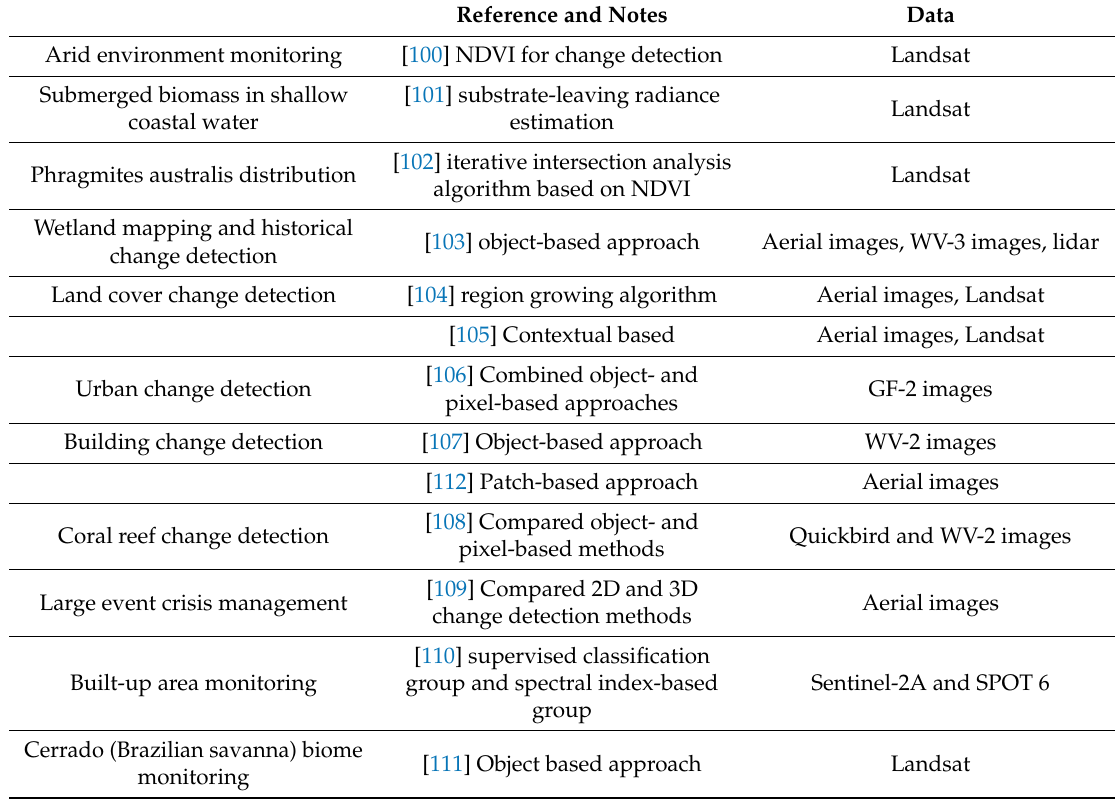
Table 3. Summary of recent application-oriented change detection